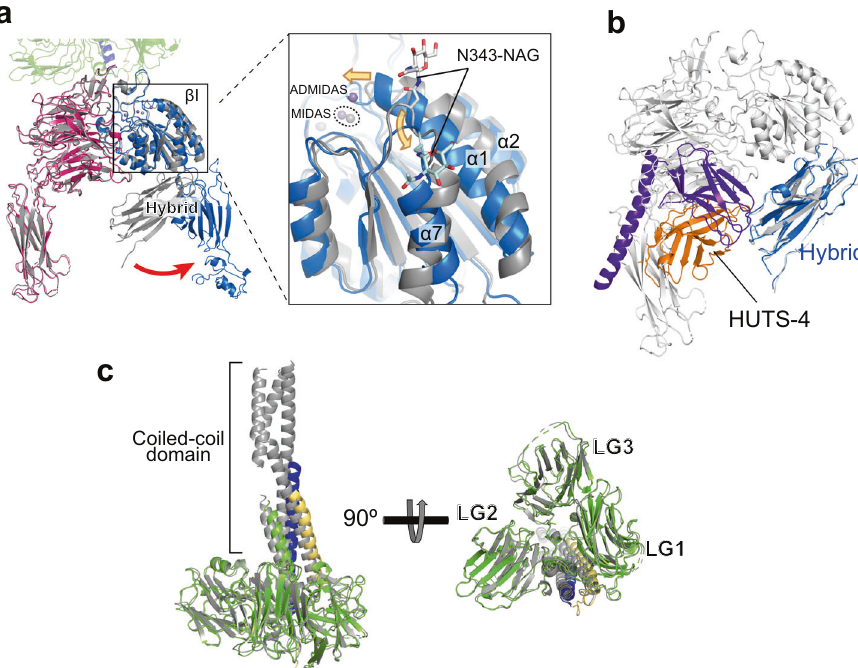
Fig. 4 Structural changes upon ligand binding. a Comparison of α 6 β 1 headpiece conformations before and after ligand binding. The crystal structure of unliganded α 6 β 1 headpiece (gray) was superposed at the β I domain onto the cryo-EM structure of the LM511 complex (color-coded as in Fig. 3b). An expanded view near the β I MIDAS (boxed) is shown in the right. The global conformational rearrangement ( i.e ., a swing-out of the β 1 hybrid domain) and the local conformational rearrangement (i.e., shifts in α 1 and α 7 helices) are denoted by red and orange arrows, respectively. The N -acetylglucosamine (NAG) residue attached to N343 is shown in stick model. b . HUTS-4 cannot bind to the tucked hybrid domain in the closed headpiece conformation. The hybrid domain and HUTS-4 in the cryo-EM structure (color-coded as in Fig. 3b) was superposed at the hybrid domain onto the crystal structure of closed α 6 β 1 headpiece (gray). c LM511 does not undergo conformational change. The crystal structure of tLM511 (PDB ID: 5xau, gray) was superposed onto the cryo-EM structure (color-coded as in Fig. 3b) at the LG1-3